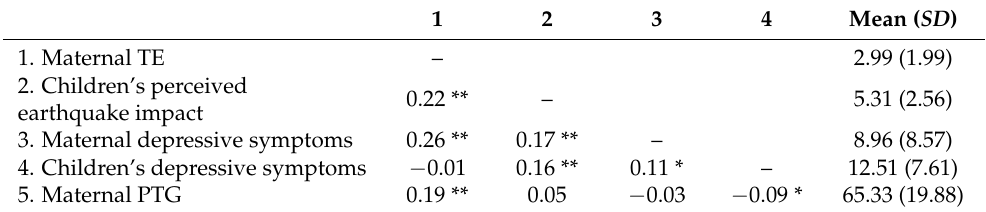
Table 2. Means, standard deviations, and correlations among the study variables ( n =